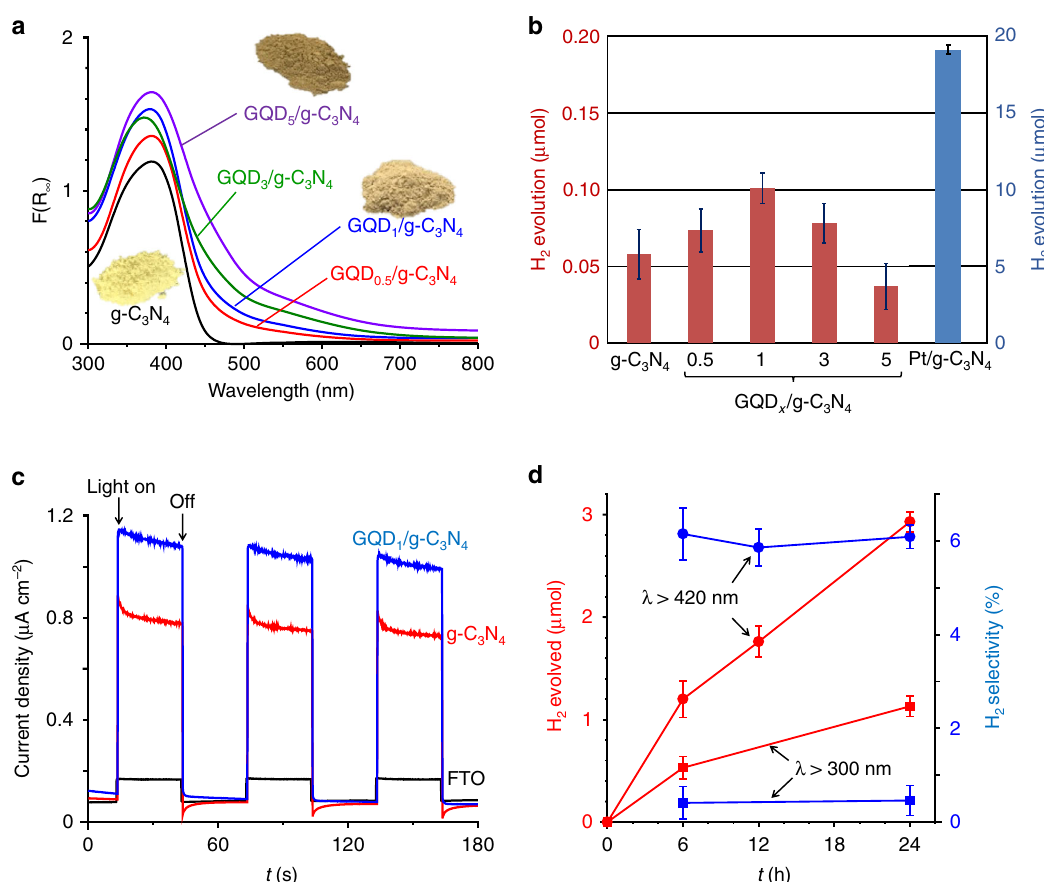
Fig. 1 Properties of GQD x /g-C 3 N 4 photocatalysts. a DR UV-vis spectra of catalysts. b Amounts of H 2 evolved on the respective catalysts in water containing TEOA as a sacri fi cial electron donor performed in a closed system (0.1 MPa Ar). Conditions: catalyst (100 mg), a water/TEOA (9/1 v/v) mixture (30 mL), light irradiation ( λ > 420 nm, Xe lamp), room temperature, and photoirradiation time (6 h). Error bars represent standard error (s.e.) determined by three independent experiments. c Photocurrent response of the catalysts measured on an FTO glass in 0.1 M Na 2 SO 4 solution at a bias of 0.8 V vs Ag/ AgCl. d Time-dependent change in the amount of H 2 evolved and the H 2 selectivity during photoirradiation of the entire wavelength light ( λ > 300 nm) or λ > 420 nm light in a closed gas circulation system (3 kPa Ar). Conditions: catalyst (200 mg), H 2 O 2 (10 mM, 100 mL), H 3 PO 4 (1 M), temperature (293 K), and light irradiation (solar simulator with AM 1.5 G fi lter, 1-sun). Error bars represent standard error (s.e.) determined by three independent